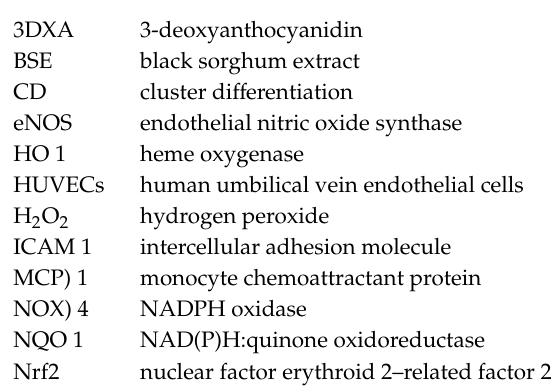
Supplementary Materials: Supplementary Figure S1, Table S1 and Table S2 demonstrate the key findings from the study of Rao et al. [14] using the UHPLC online ABTS system, and DPPH and FRAP assays. Table S3 represents the amplification e ffi ciency of primers used in this